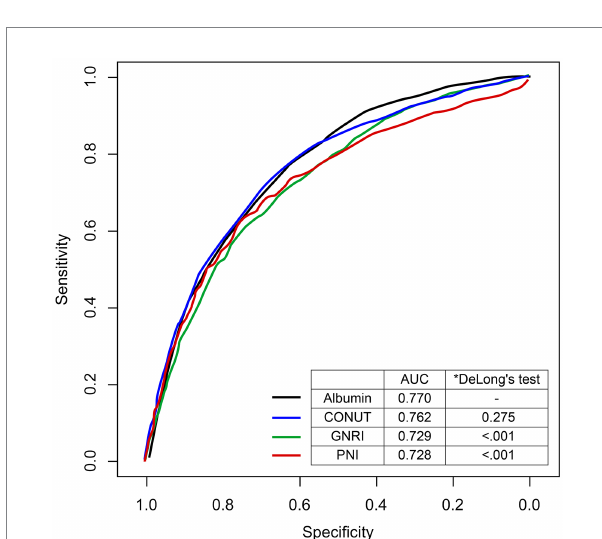
FIGURE 2 The receiver-operating characteristic curve comparing the predictive performances for delirium. The predictive performances of nutritional indices were calculated using Delong’s test and compared to those of albumin. AUC, area under the curve; CONUT, Controlling Nutritional Status; GNRI, Geriatric Nutritional Risk Index; PNI, Prognostic Nutritional